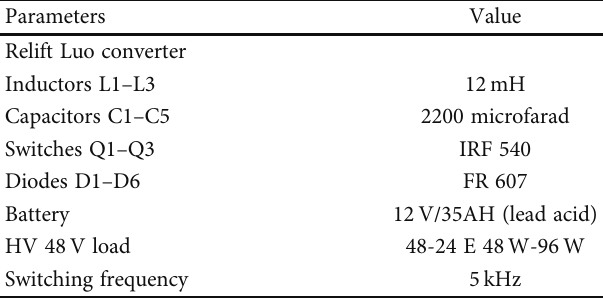
Table 4: The speci fi cations of the SLLC, the battery, and the HV